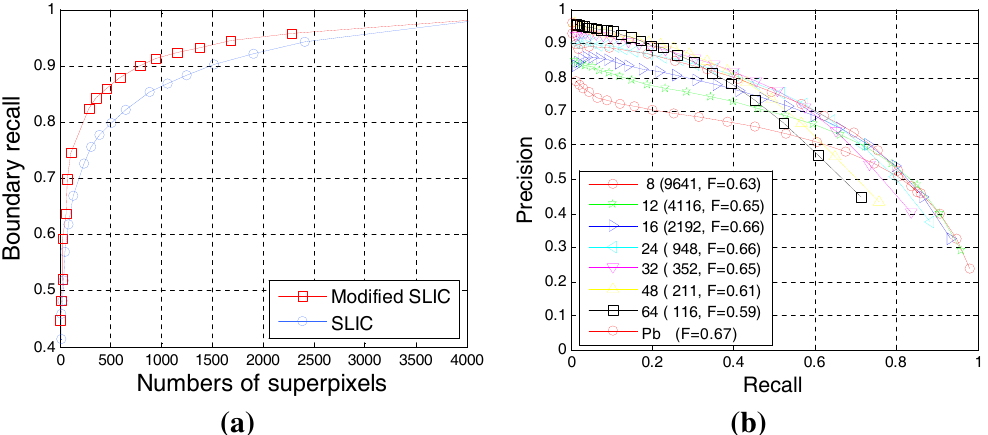
Figure 4. ( a ) Plot of the boundary recall w.r.t. the number of superpixels; ( b ) P-Rcurve comparison with our method under different initial grid intervals and Pb [26] ; values inside those parentheses of the legend are the number of superpixels corresponding to the initial grid interval and its